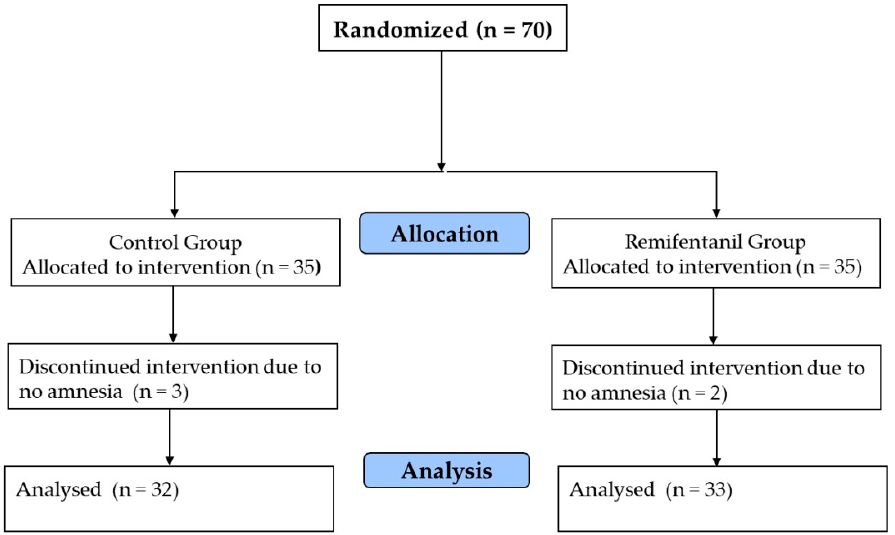
Figure 1. Randomization and study flow diagram. Table 1. Demographics and Baseline Hemodynamics of the Study Patients.